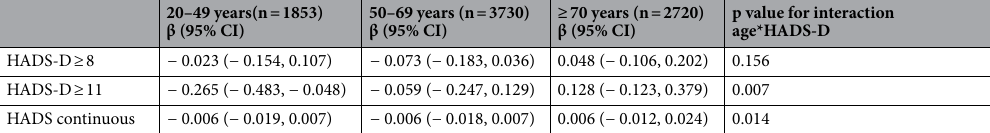
Table 5. Age-stratified association of depression and albuminuria in linear regression models with ACR as continuous dependent variable. Mulitvariable adjusted for age, sex, systolic blood pressure, waist circumference, cholesterol, creatinine, cardiovascular disease, daily smoking cigarettes, treated hypertension, diabetes, education, and hard physical activity. ACR albumin/creatinine